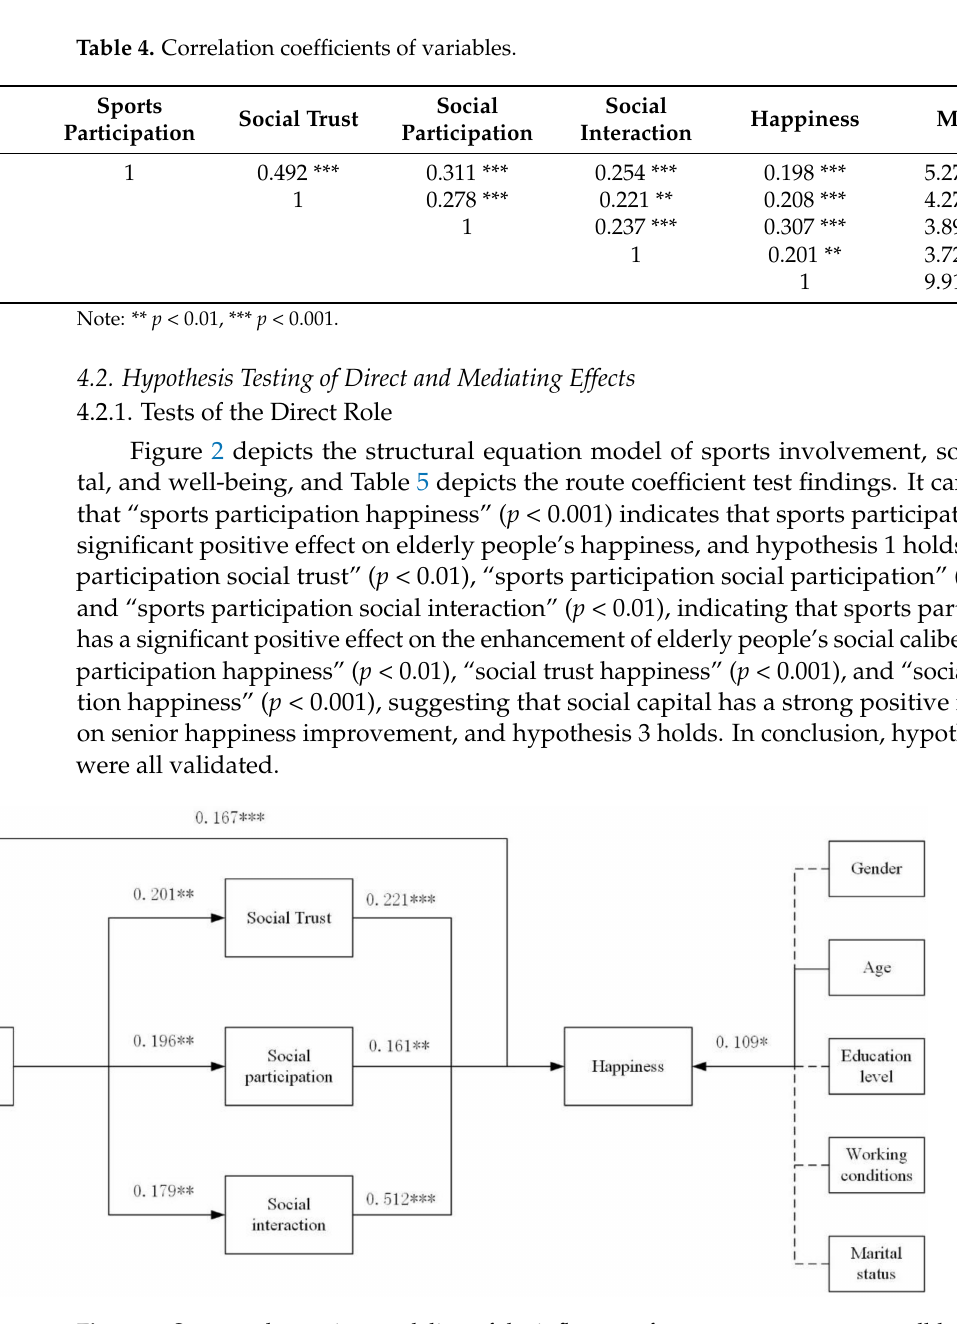
Figure 2. Structural equation modeling of the influence of sports engagement on well-being. Note: